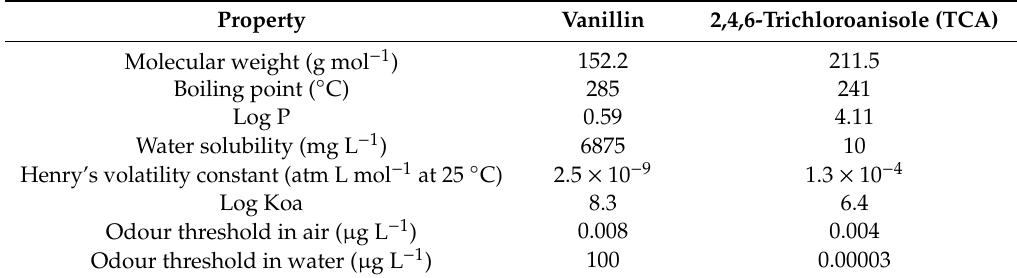
Table 1. Basic chemophysical properties and odour thresholds of vanillin and 2,4,6-trichloroanisol (TCA), two powerful odorants of very di ff erent